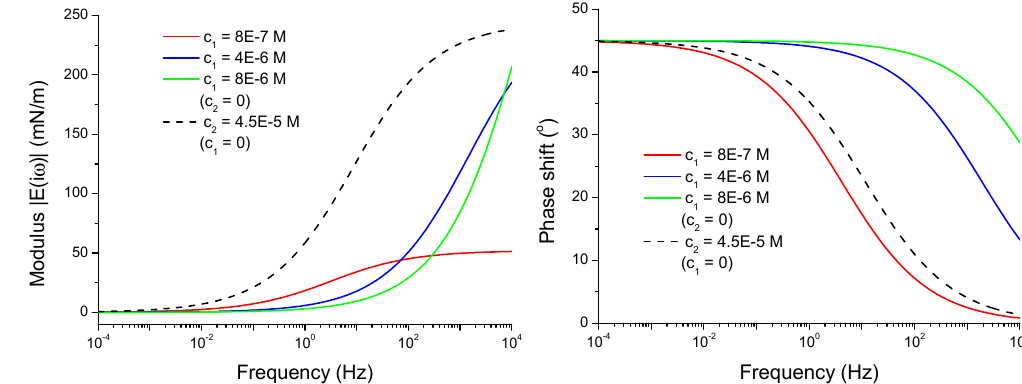
( ) ω Figure 6. Viscoelasticity modulus | E ( i ω ) | and phase shift ϕ ( ω ) of individual adsorption layers as iE and phase shift φ ( ω ) of individual adsorption layers as Figure 6. Viscoelasticity modulus = 8.0 × 10 − 7 , 4.0 × 10 − 6 and functions of frequency calculated according to Equation (3) for c α 1 = α c 8.0 × 10 − 7 , 4.0 × 10 − 6 and 8.0 × functions of frequency calculated according to Equation (3) for = 0 (full lines) and for c α = 4.5 × 10 − 5 mol/dm 3 at c α = 0 (dashed line). 8.0 × 10 − 6 mol/dm 3 at c α 1 2 2 1 = α c 0 (full lines) and for = α c 4.5 × 10 − 5 mol/dm 3 at = α c 0 (dashed line). 10 − 6 mol/dm 3 at 2 2 1